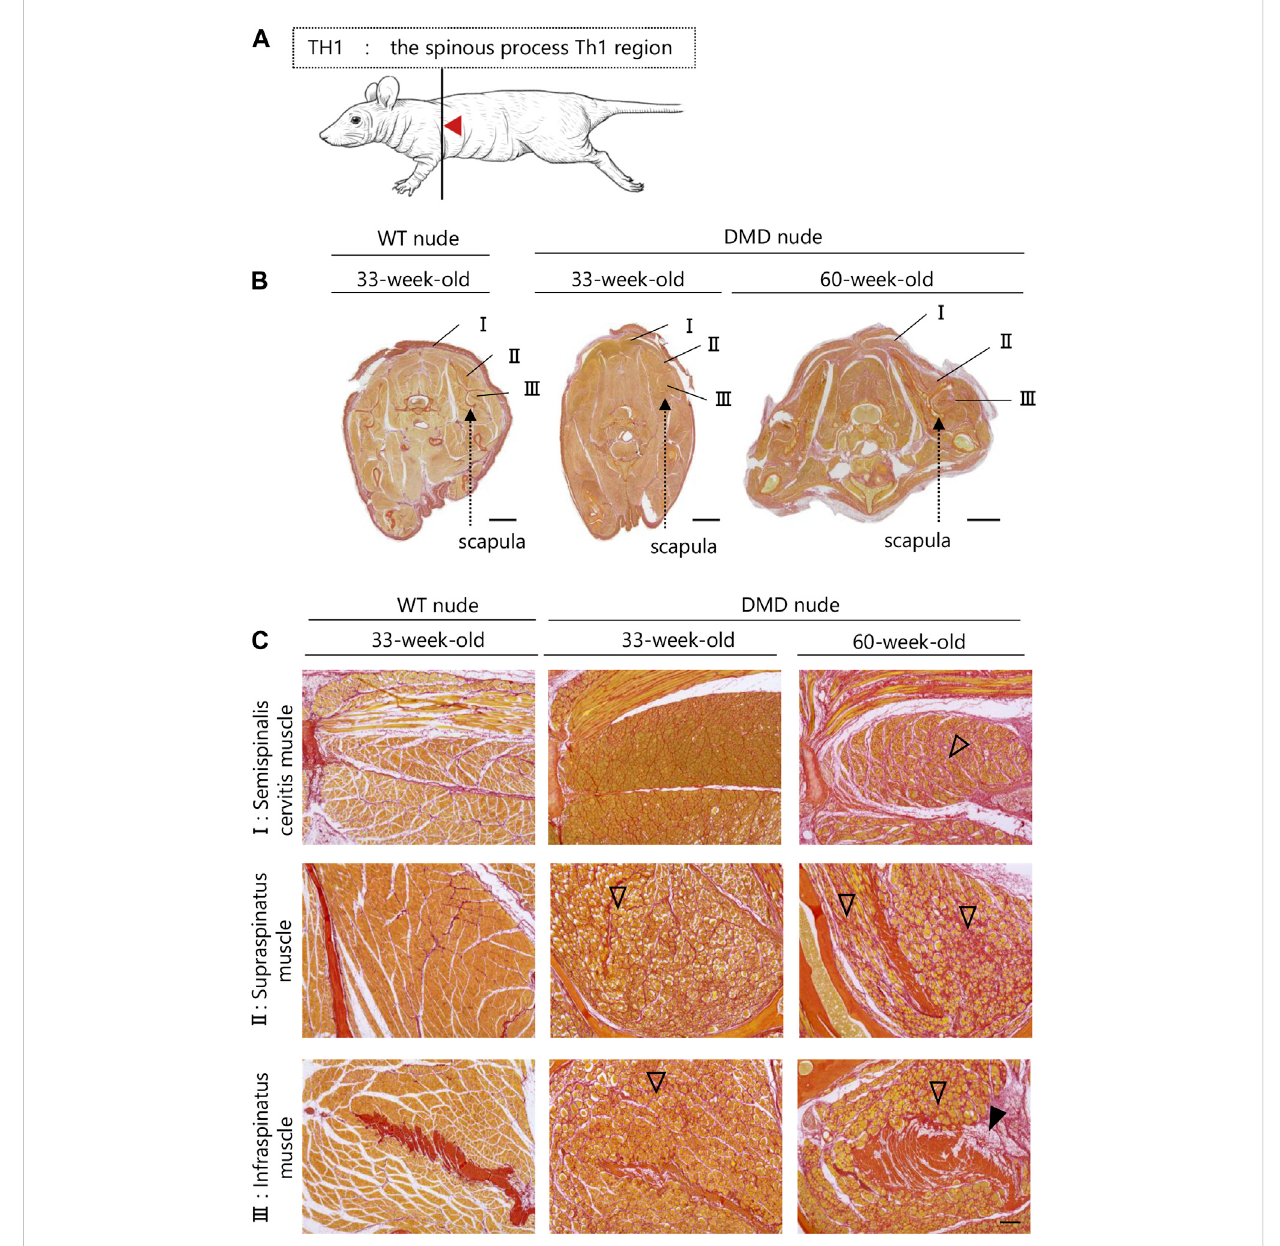
FIGURE 5 Lesiondistributionwithintheskeletalmuscle intransversesectionsinDMD nuderats. (A) Schematic drawingshowingthesectioning locationofthe shoulderandrump.ThecutsweremadeinthespinousprocessoftheTh1region(Th1). (B) RepresentativeimagesofSiriusred(SR)staininginTh1shoulder sectionsofeachrattypetoevaluatethedegreeof fi brosis.Scalebar=5 mm. (C) Magni fi edviewsofI,II,andIIIindicatedbyarrowsareshowninthelower columns. Scale bar = 300 µm. The symbols, ▽ and ▼ , indicate fi brosis and adipogenesis,